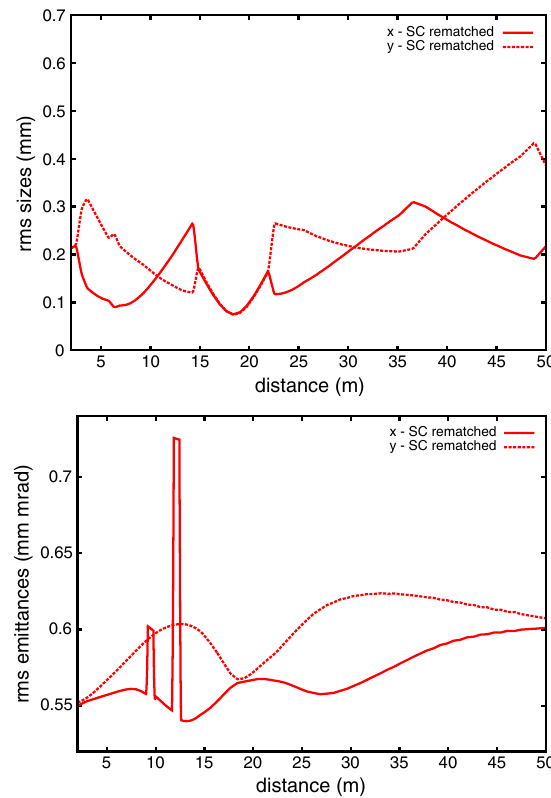
FIG. 6. Evolution of transverse rms sizes (top) and transverse rms emittances (bottom) with rematched space-charge effects in the